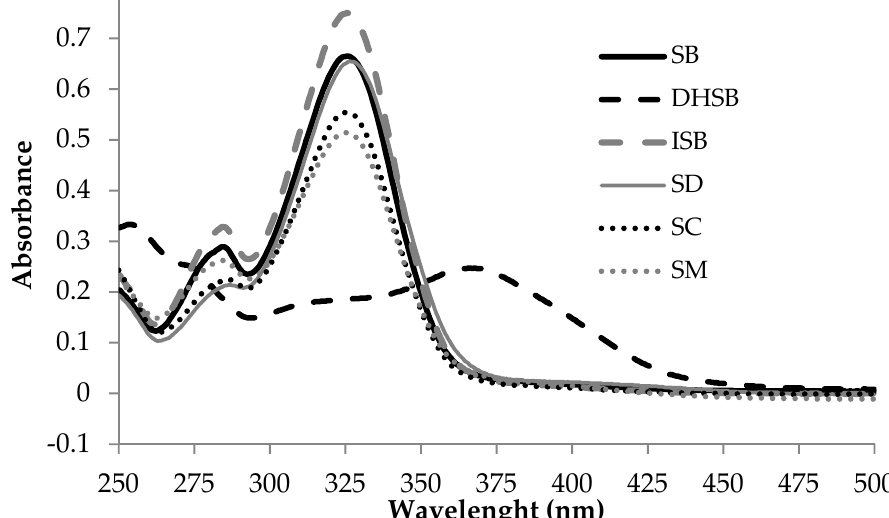
Figure 2. Absorption spectra of silymarin and flavonolignans (12.05 mg/L in 0.5% DMSO in PBS pH 7.5).